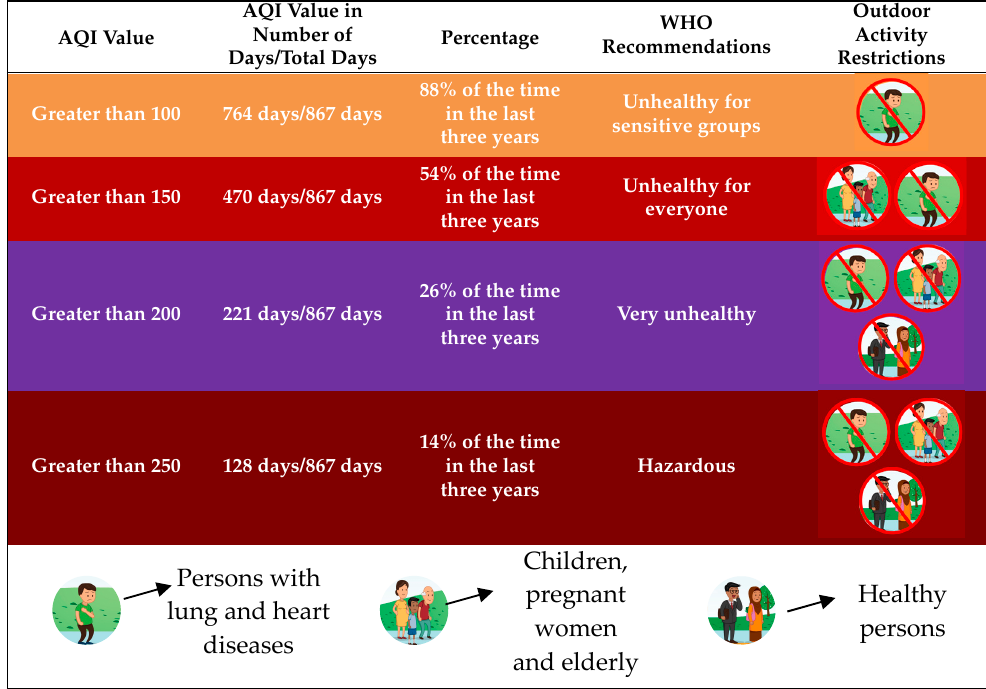
Table 2. Lahore AQI values and their effects on human life.